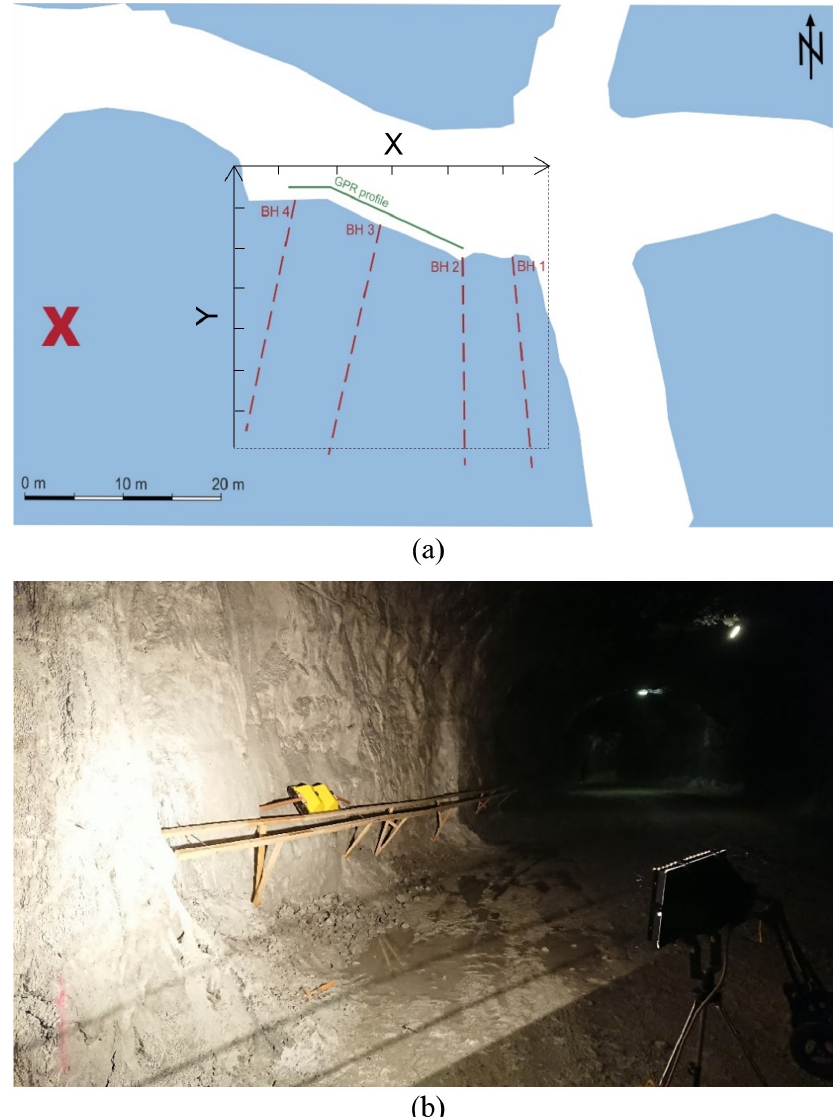
Figure 1. ( a ) Map view of the survey area. The green line marks the profile measured with the radar in reflection mode. The doted red line indicates the boreholes that were used for the crosshole tomography. The red cross marks the rockfall that occurred in the mining chamber one level below the measurements. The X and Y axes depict the coordinate system used for further measurements. Note the Y axes has denser tick marks as it is projected to a horizontal plane ( b ) ground-penetrating radar (GPR) profile and the 250 MHz antenna. Penetration depth would have been strongly a ff ected by mud and puddles if the measurements were carried out on the